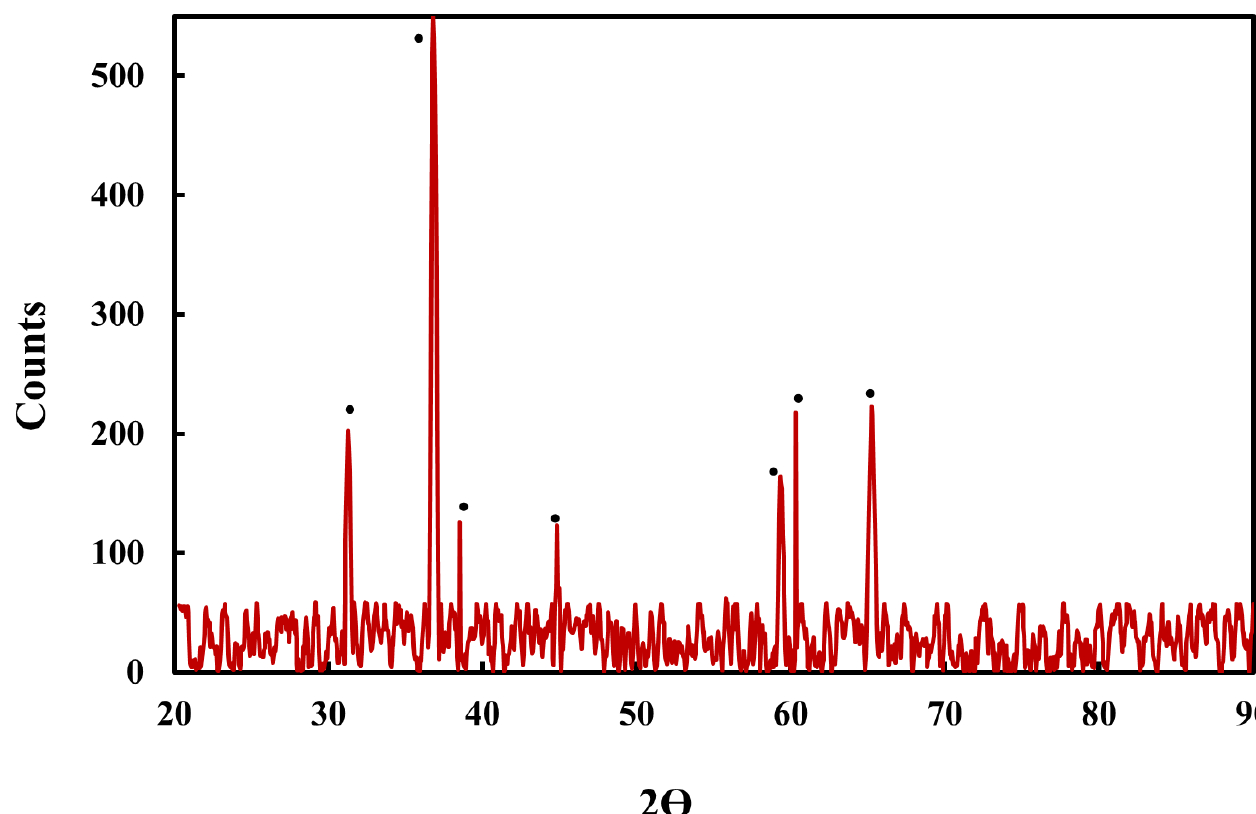
Figure 7. X-ray diffraction pattern of Co 3 O 4 NPs synthesized using rosemary leaf extract.